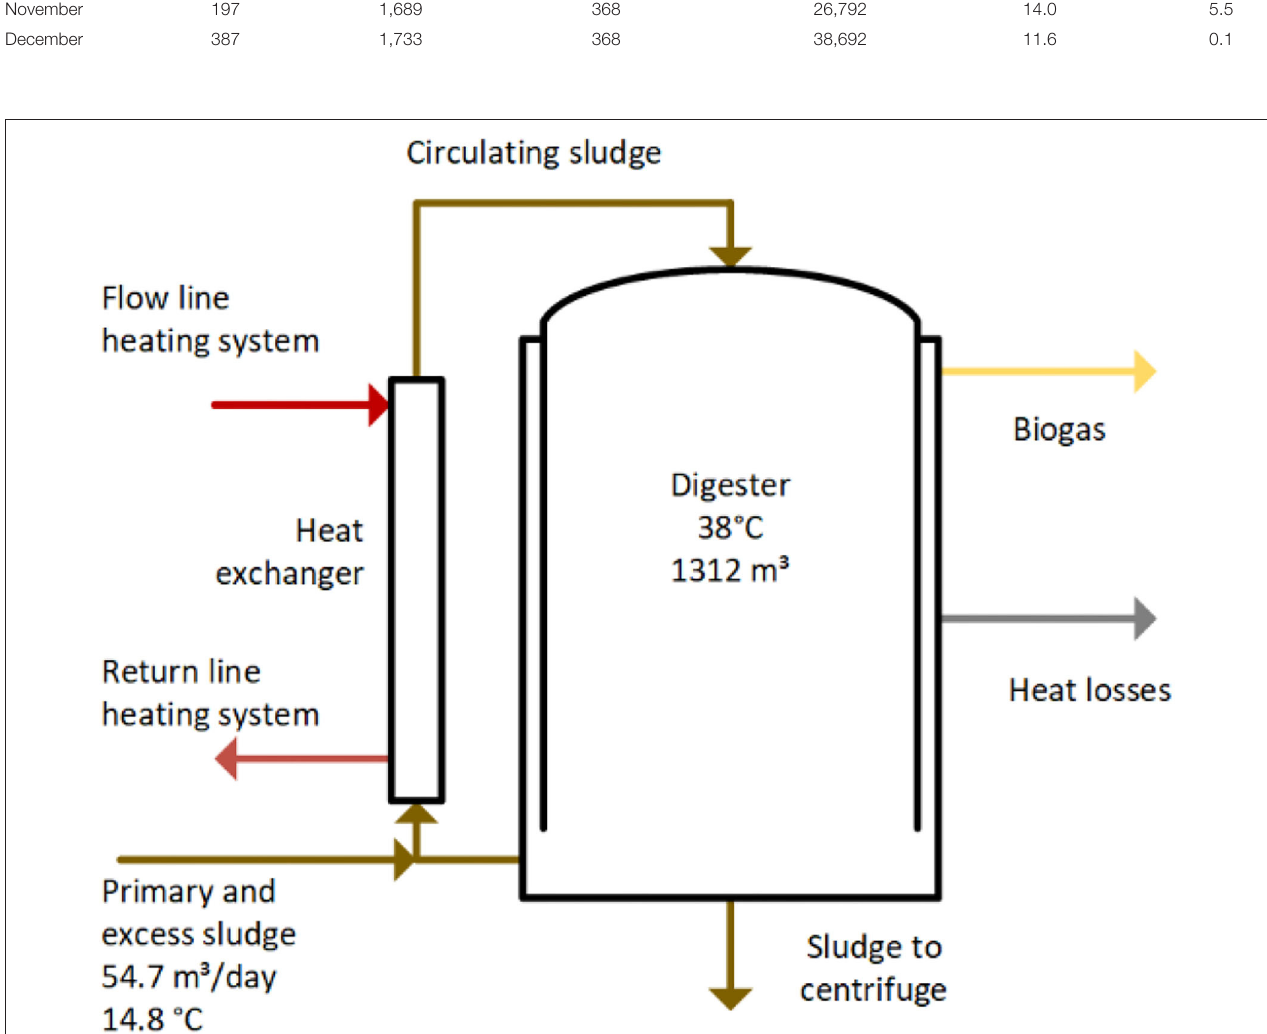
FIGURE 2 | Thermal energy balance of the